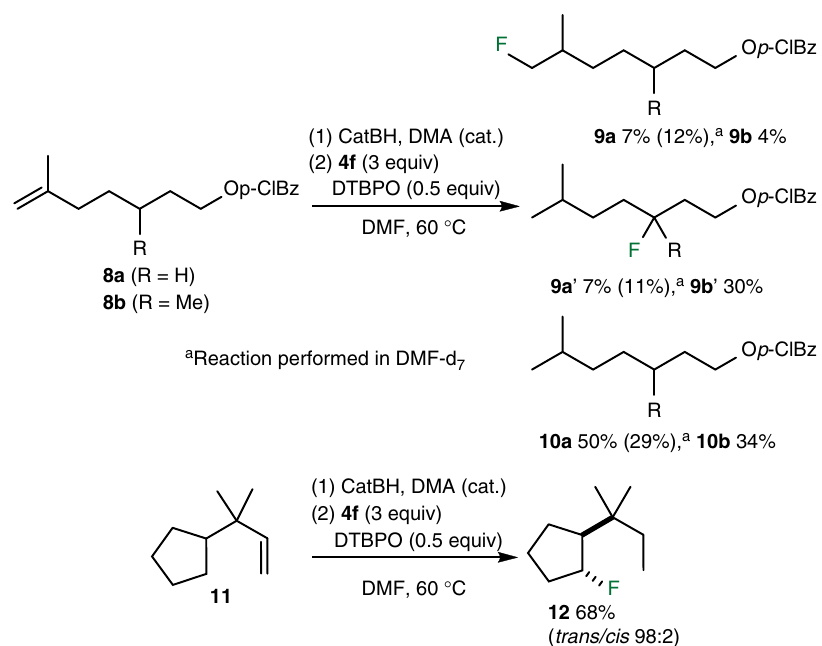
Fig. 6 Hydro fl uorination of terminal alkenes. The lower nucleophilicity of primary alkyl radical slows the direct fl uorination and favors hydrogen atom abstraction processes leading to remote fl uorination of unactivated C – H bonds ( p -ClBz = para